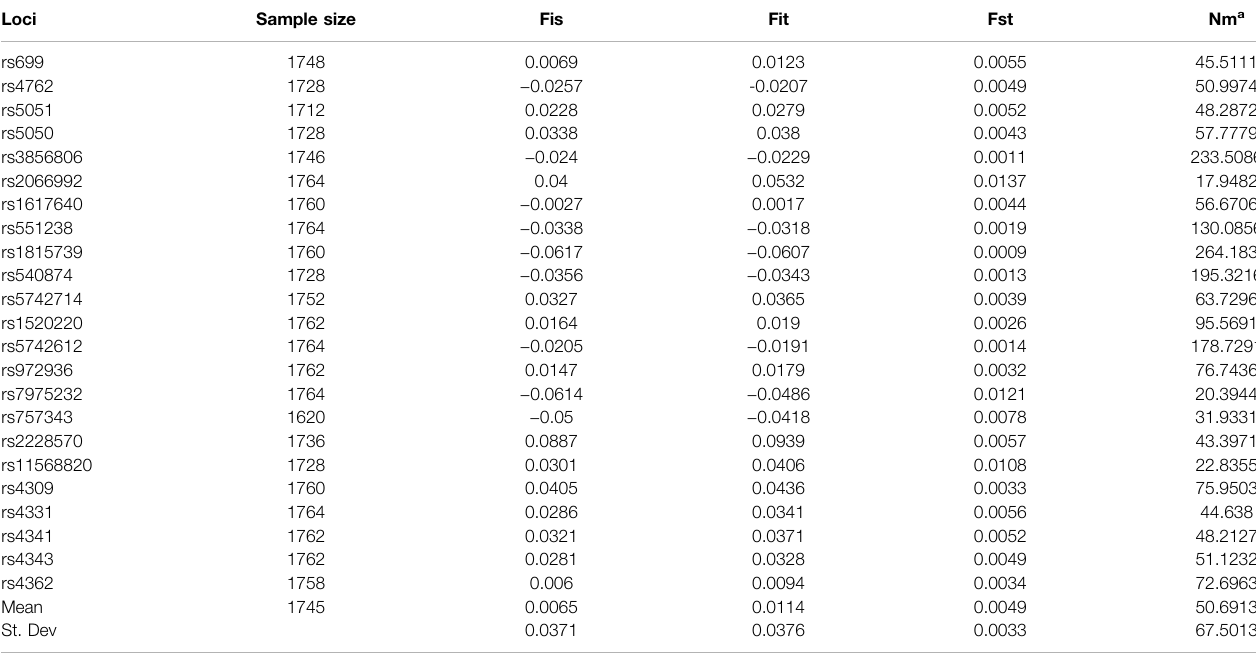
TABLE 5 | Summary of the F-Statistics and gene fl ow for all the SNPs in fi ve populations. Loci Sample